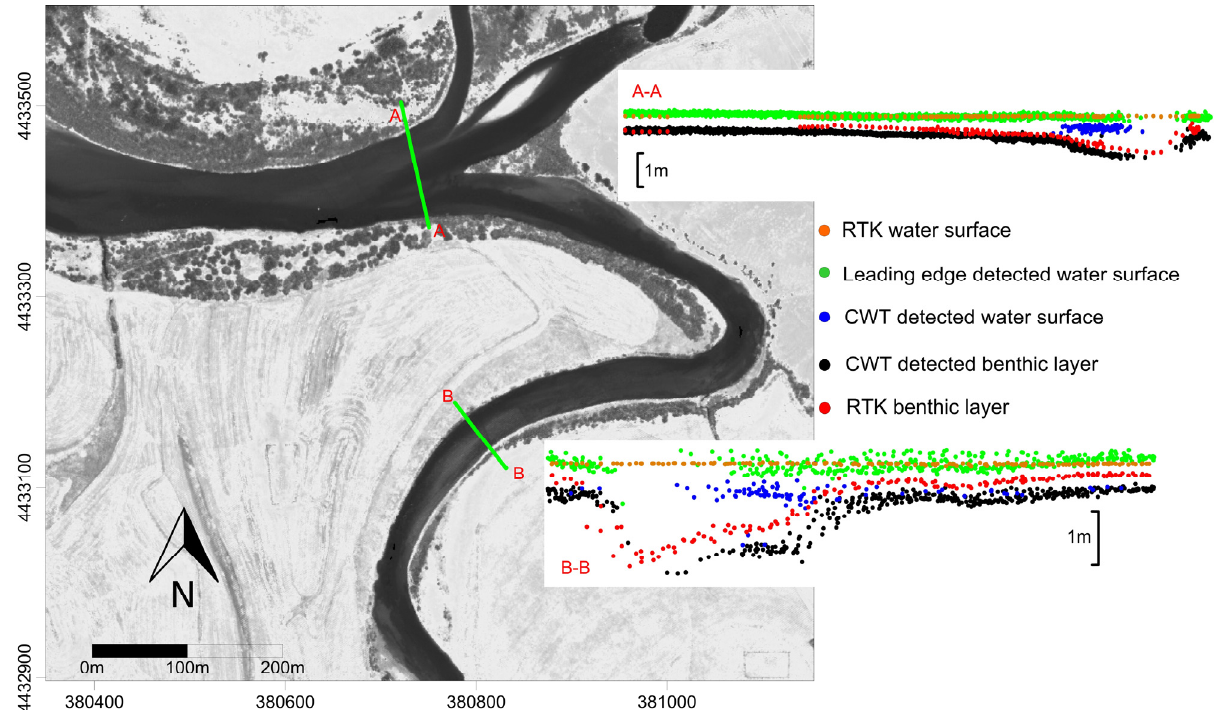
Figure 14. Profiles for leading edge detected water surface on the Blue/Colorado River. The CWT detected waveform shows a clear vertical bias from the RTK water surface while the leading edge detected water surface is much closer to the RTK water surface. Coordinates are in UTM 13N